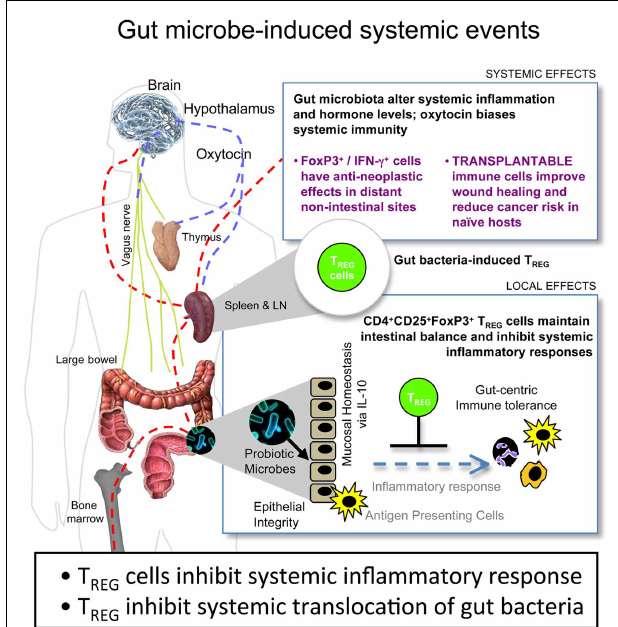
FIGURE 1 | Gut bacteria–host crosstalk is continuous and reciprocal in the cancer macroenvironment . Beneficial microbes trigger IL-10-mediated GI-tract immune and neuronal networks that lower systemic inflammatory tone and up-regulate hypothalamic–hypophyseal targets, including oxytocin, constituting a gut–systemic immunity-endocrine-axis. In this way, microbiota stimulate CD4 + lymphocytes including regulatoryT cells (T REG ) that suppress, promote, or have no effect in carcinogenesis depending upon their timing and prior exposure to gut bacterial antigens and presence of interleukin (IL)-10.This places neoplastic development and growth into a new broader context of the holobiont (comprised of the mammalian host plus resident microbes) and the cancer macroenvironment, highlighting microbes that may be engineered for sustained good